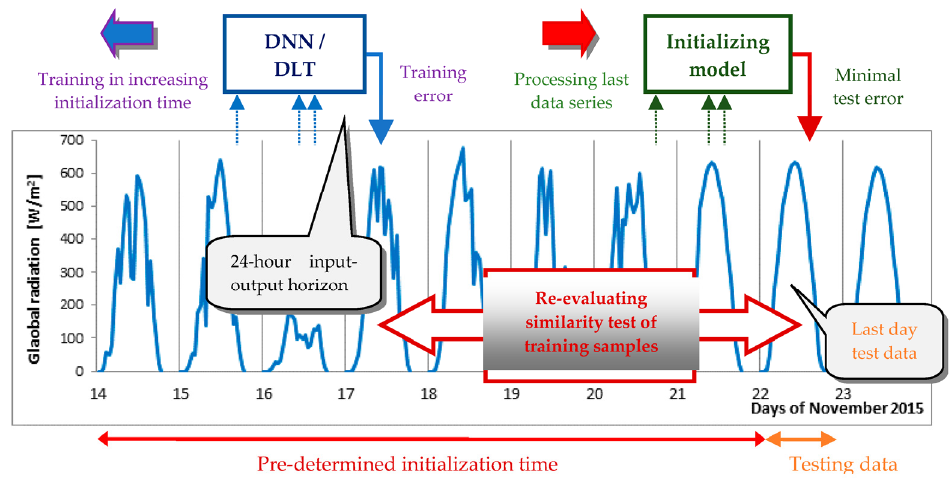
Figure 1. First detection of the model initial time with reappraisal of data records, one-by-one.